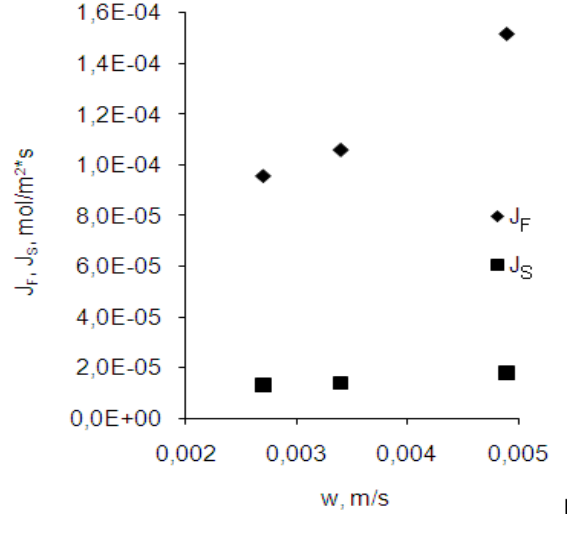
) and exit (J ) fluxes with membrane flow velocity F S = 5.8·10 -5 mol·m -3 p